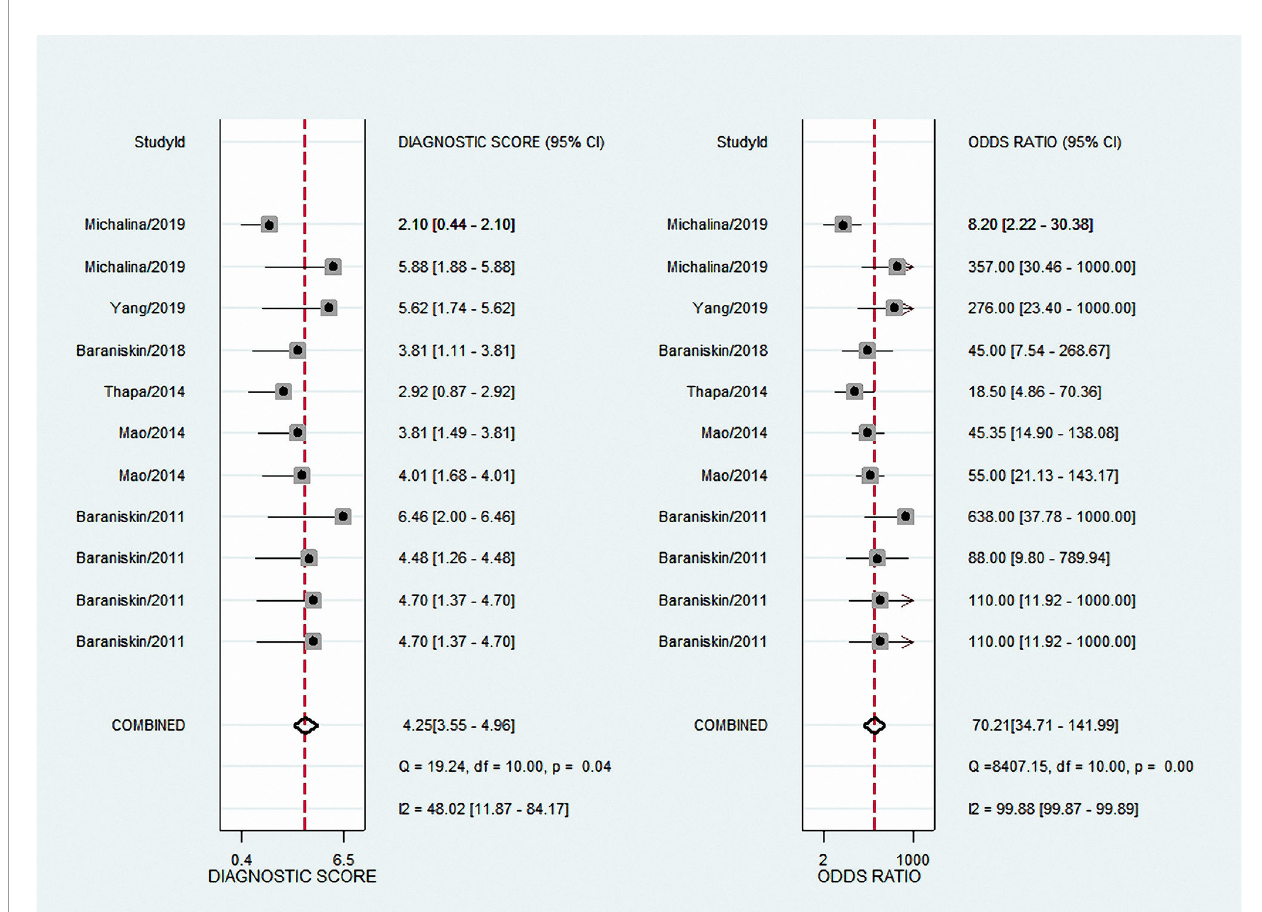
FIGURE 4 | Forest plots of DOR for total miRNA levels of 11 studies in the diagnosis of PCNSL. DOR, diagnostic odds ratio; PCNSL, primary central nervous system